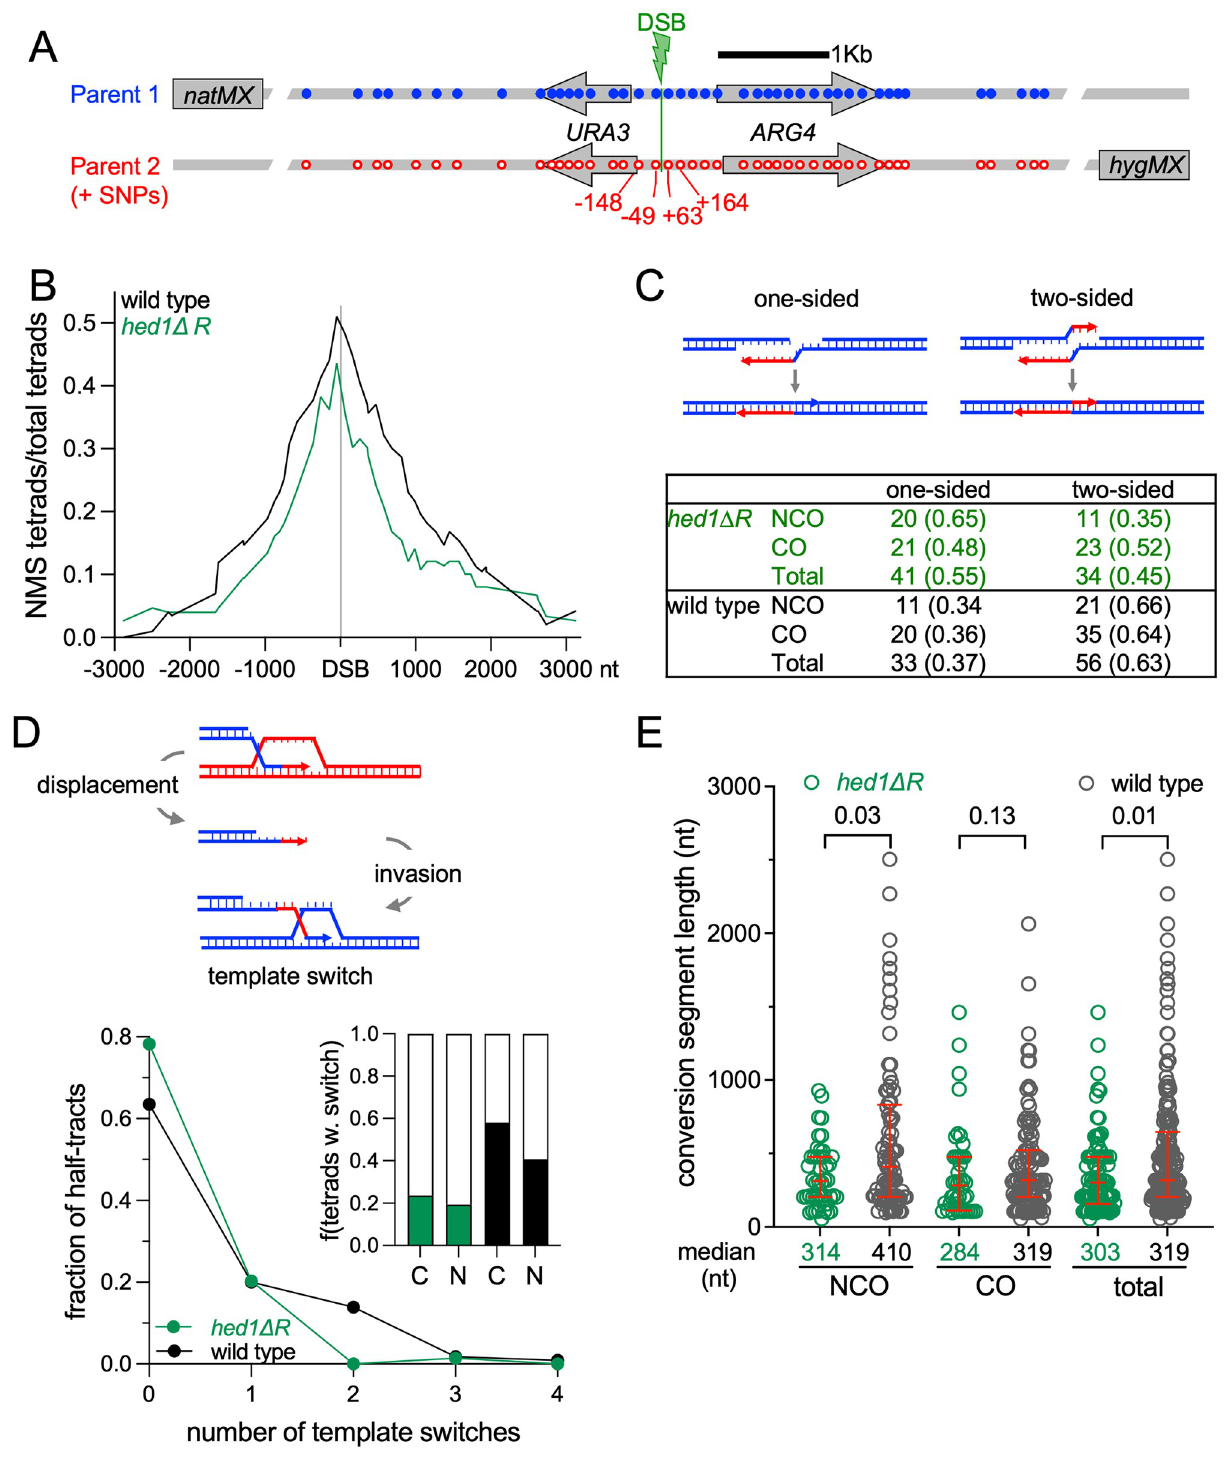
Fig 7. Constitutive activation of Rad51 results in inefficient interhomolog strand invasion during meiosis. The URA3-tel-ARG4 recombination interval showing the position of polymorphic markers (blue—wild type; red–polymorphisms) relative to the double-strand break centroid (DSB, green lightning bolt). ~85% of DSBs form between -49 and +63; all DSBs form between -148 and +164 (Ahuja et al., 2021). Flanking drug resistance inserts allow genetic scoring of crossing-over. For the analysis, DNA was isolated from the four spores of 159 tetrads from the hed Δ R msh2 Δ diploid, NH2700. Fragments containing the hotspot region were then amplified and sequenced in their entirety. (B) Gene conversion frequencies (tetrads with